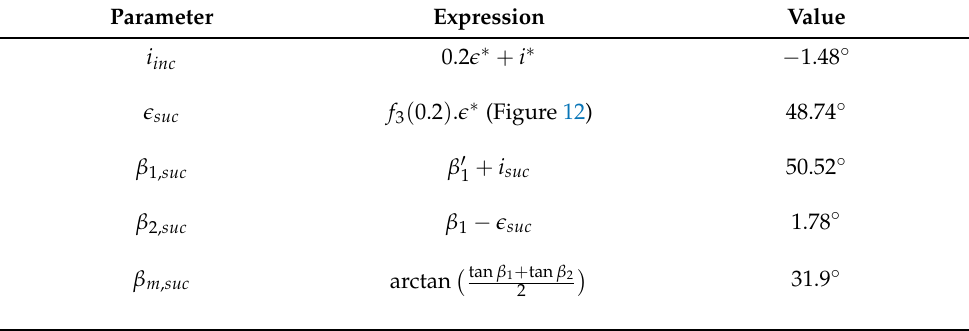
Table A1. Numerical example of the application of the cascade principles of CFFs.